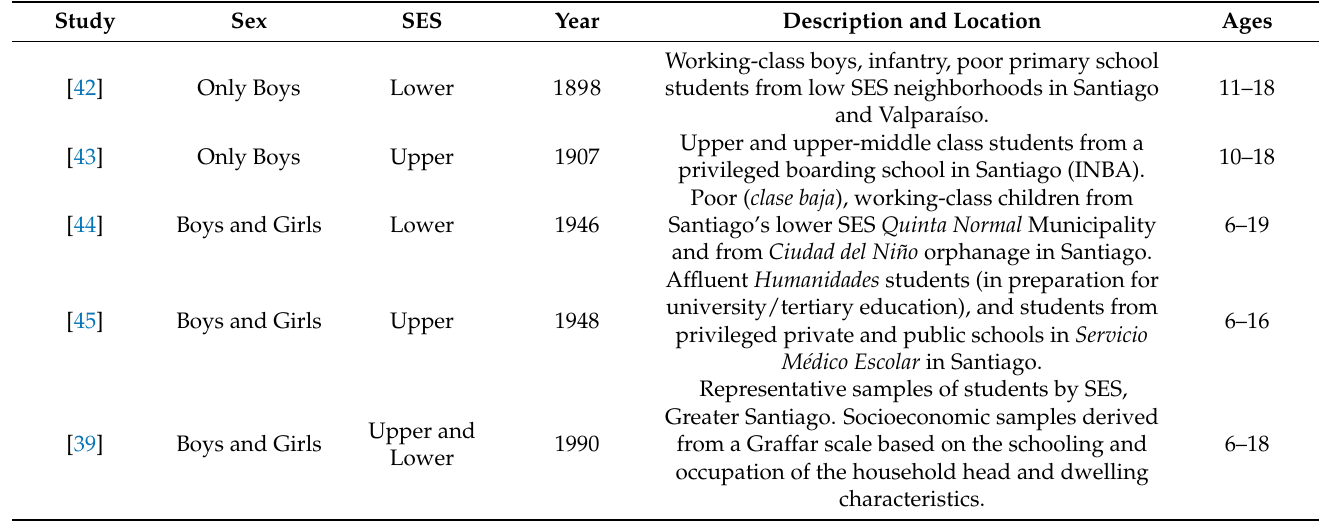
Table 1. Selected studies providing accurate information of children‘s socioeconomic